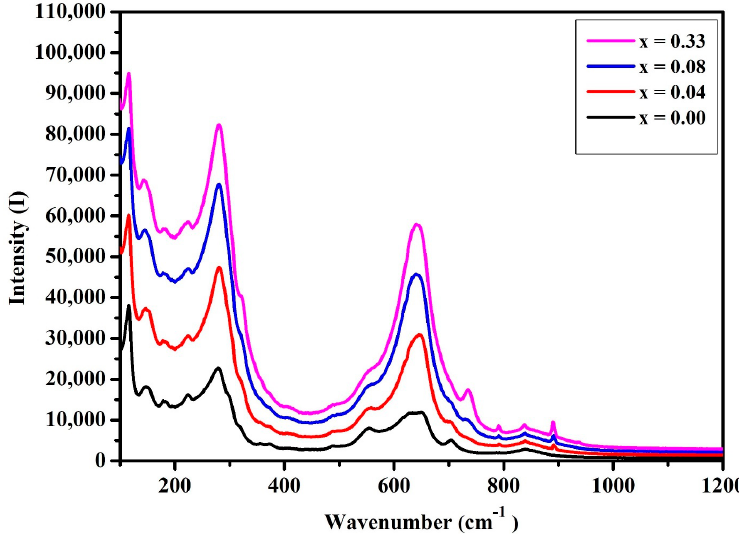
Figure 2. Crystal structure where x = 0.33, projected in 3D space ([1 1 1]).